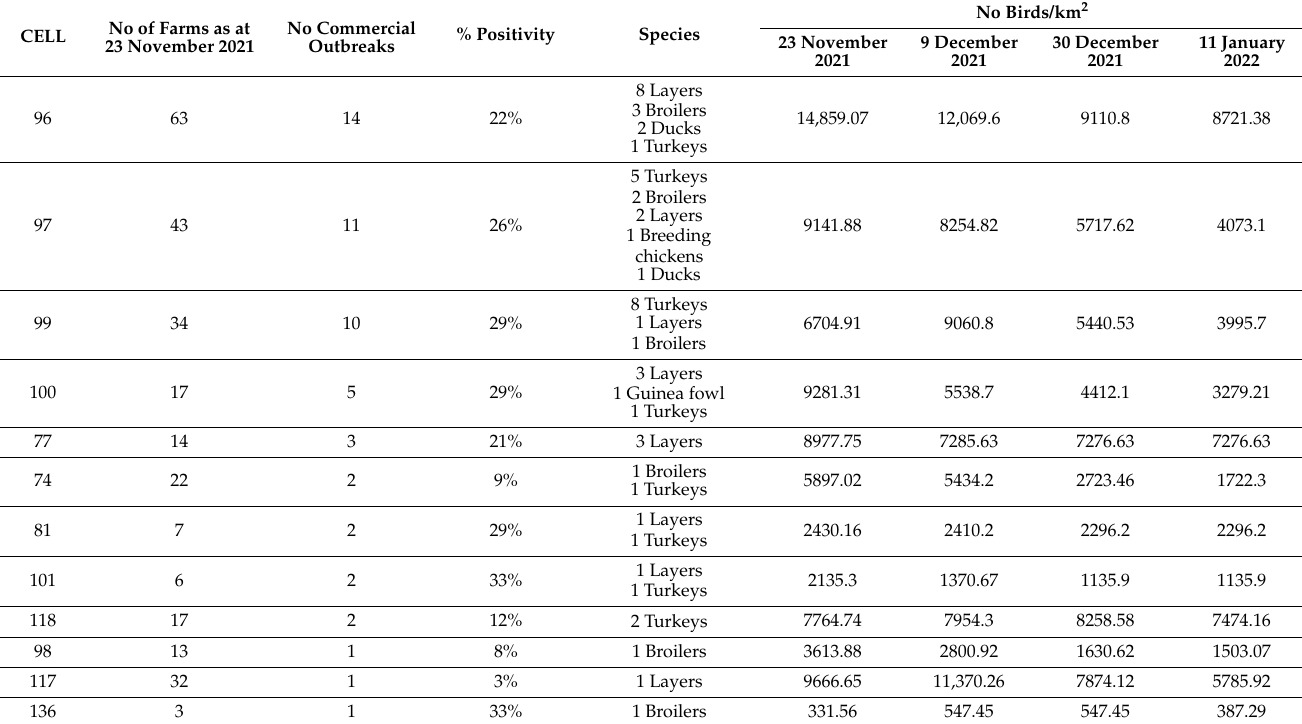
Table 4. Number of flocks and outbreaks in cells where there was at least one positive farm and the relative bird densities per km 2